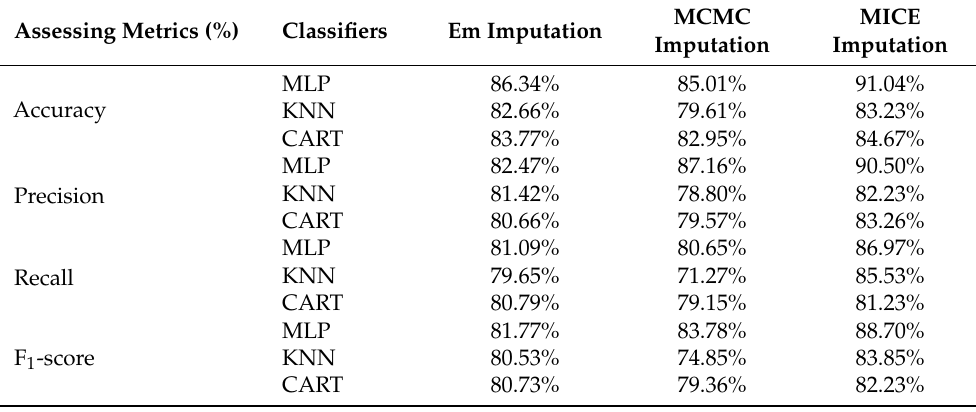
Table 3. Multiple imputation comparison on the MAR